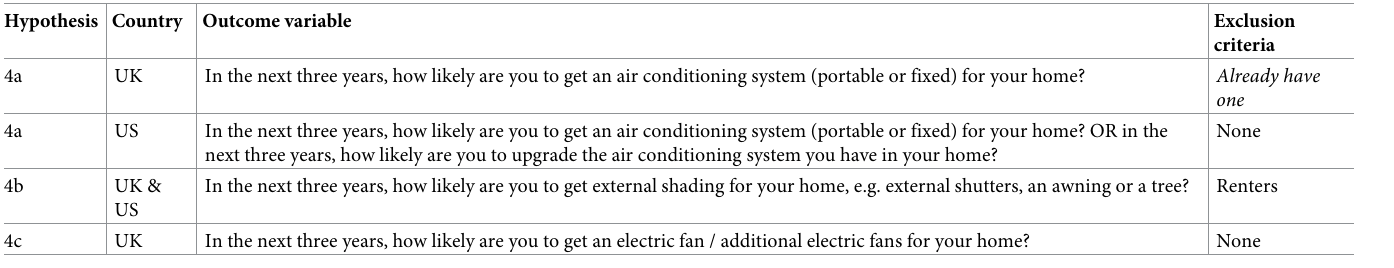
Table 9. Items to assess likeliness to install cooling devices.